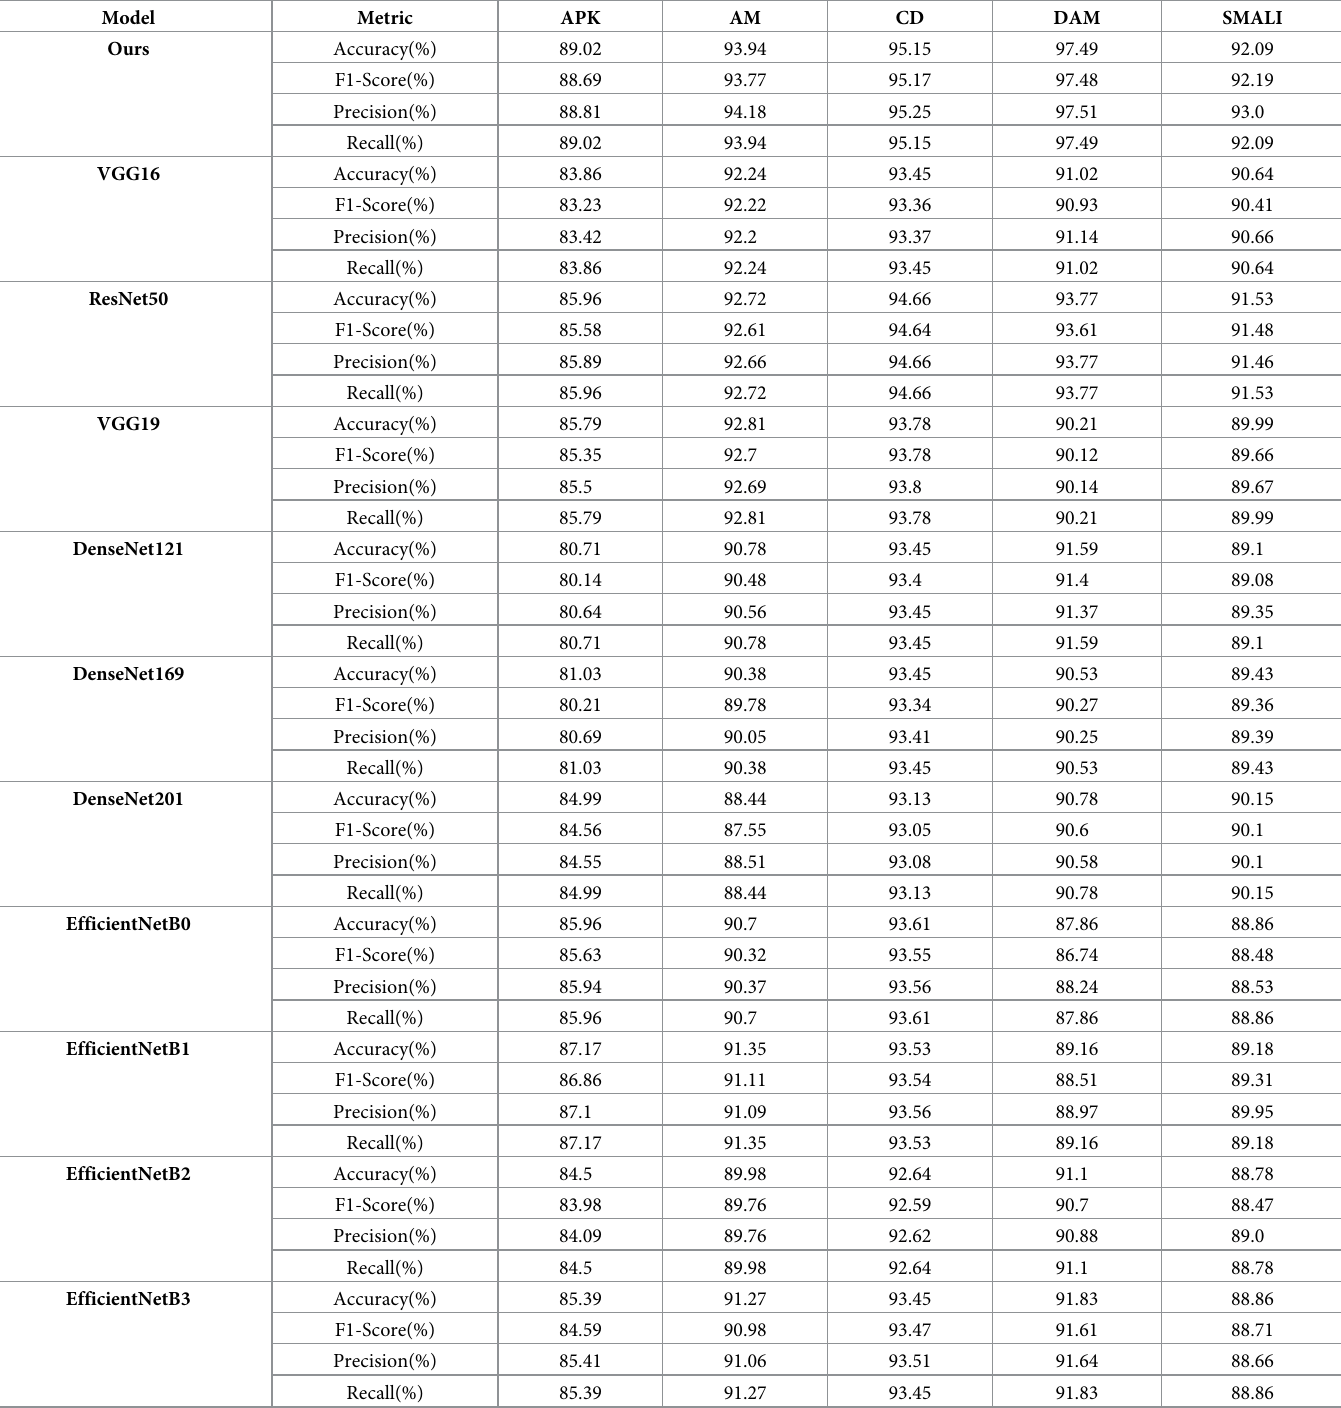
Table 6. Security performance of models on AMD